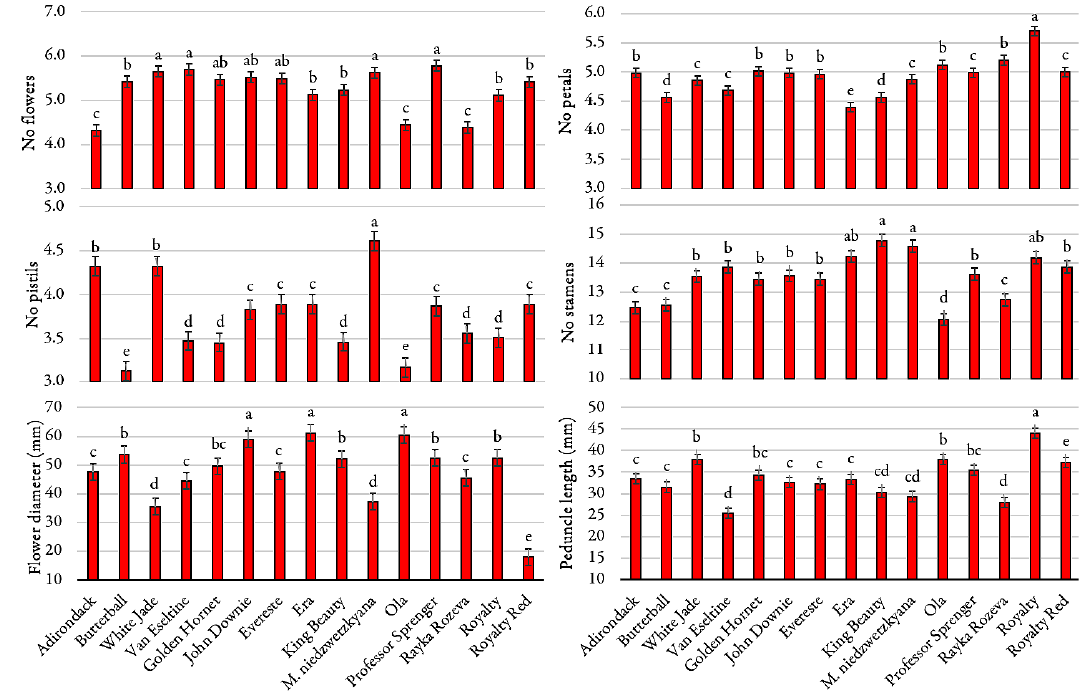
Figure 1. The main flower characteristics of the 15 cultivars of ornamental crabapples